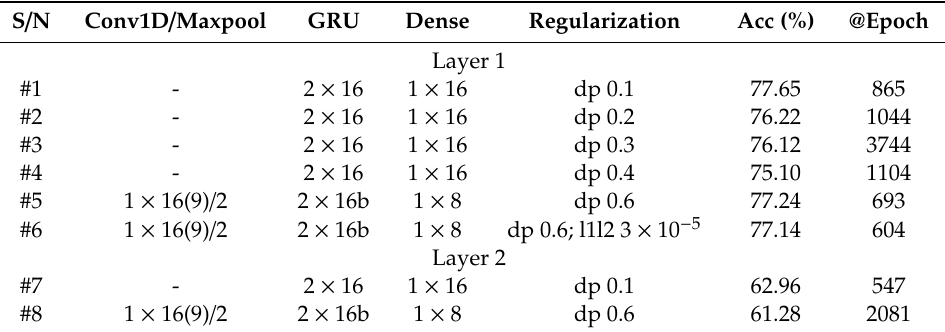
Table 3. Fine-tuning validation results.